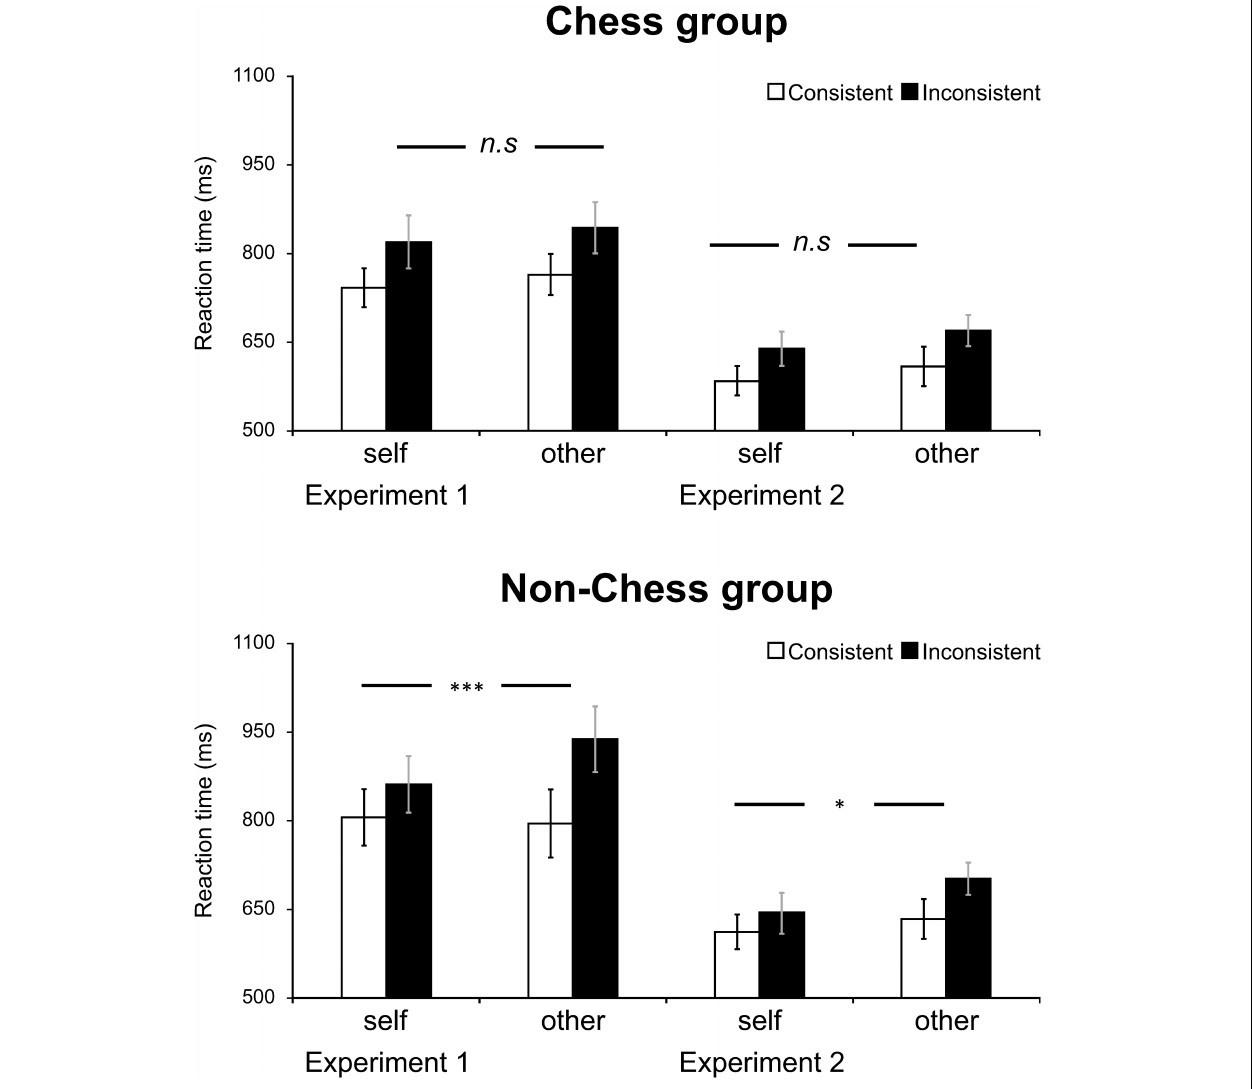
FIGURE 1 | Mean response time for each experimental condition in Experiment 1 and Experiment 2. Symbols indicate significance level ( ∗∗∗ p < 0.001; ∗∗ p < 0.01; ∗ p < 0.05; n.s = non